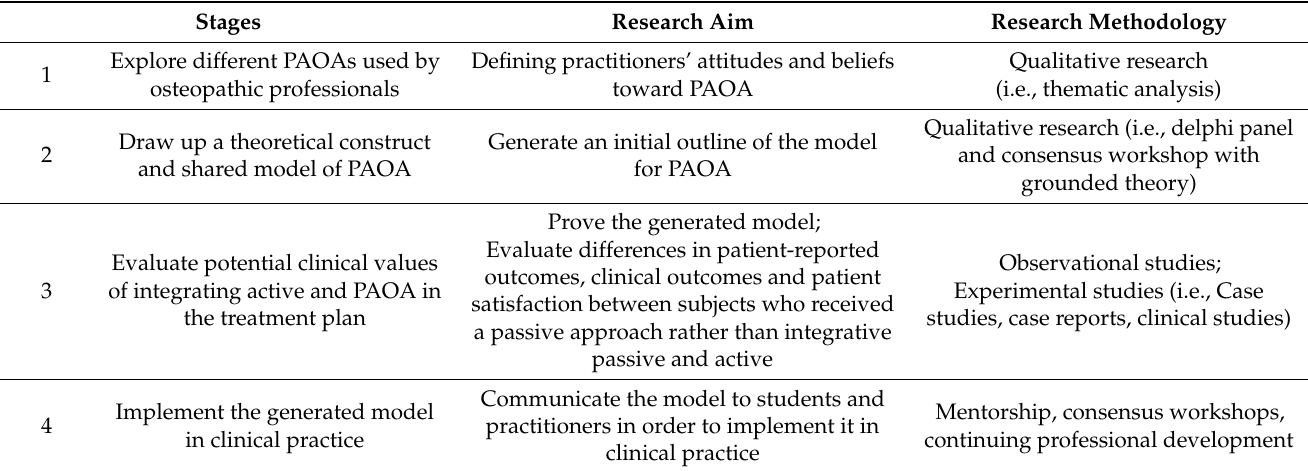
Table A2. Research roadmap for developing evidence-based clinical use of patient active osteo- pathic